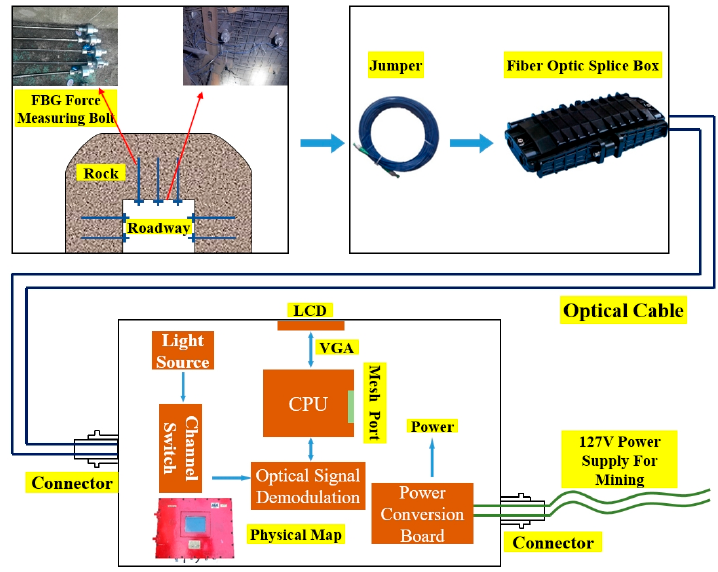
Figure 6. Hierarchical structure of the monitoring system.